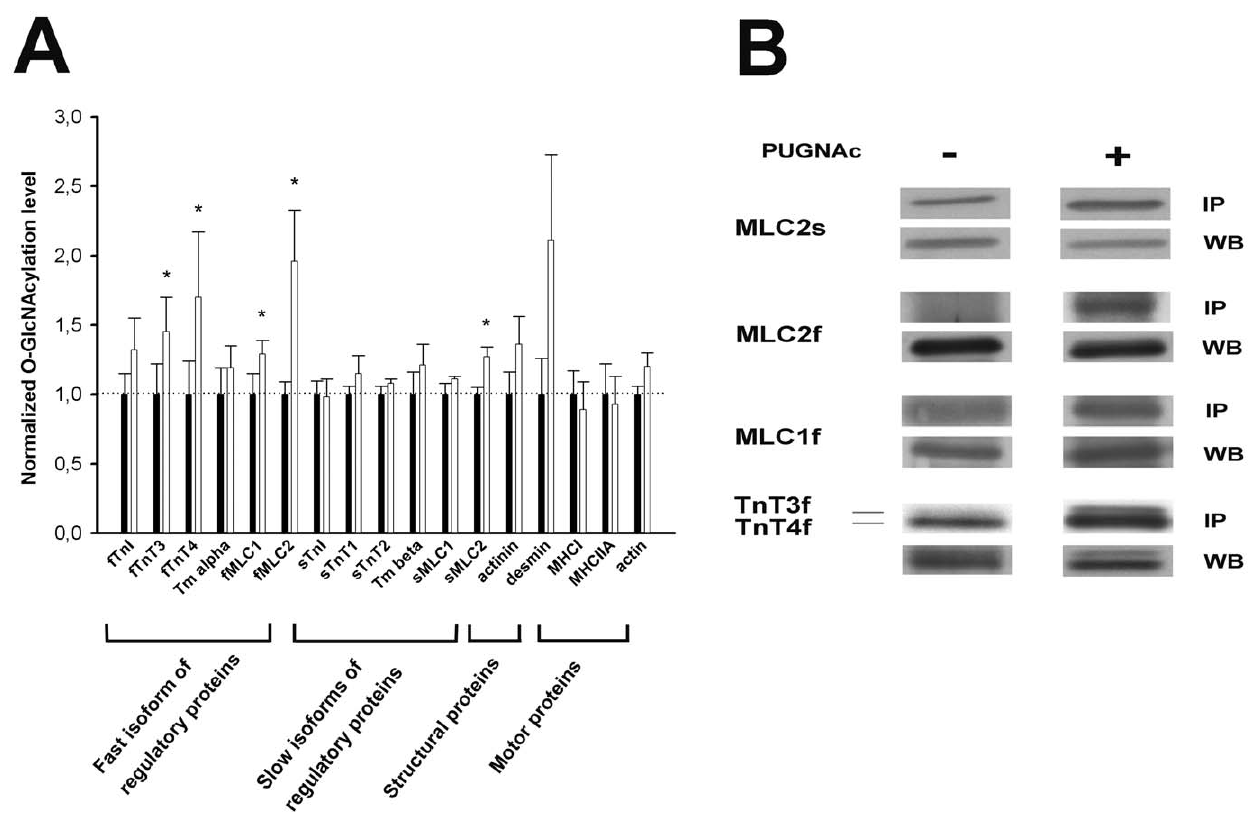
Figure 5. Quantification of O-GlcNAc variation on contractile protein after PUGNAc-treatment of soleus biopsies. Proteins extracted from skinned biopsies were RL-2 immunoprecipitated and separated on 10–20% SDS-PAGE. Densitometric analysis on QuantityOne software was performed on proteins of interest revealed using specific antibodies. (A) Results are expressed as ratio between signal obtained after RL-2 immunoprecipitation and signal obtained for whole protein level. Histograms correspond to O-GlcNAc level in PUGNAc-treated soleus comparing with untreated biopsies which were assigned to reference ( i.e. 1). Data are expressed as mean 6 SEM and are representative of 5 paired biopsies. *p , 0.05 PUGNAc vs untreated-treated biopsies. (B) Representative western blots of the proteins presenting variation in O-GlcNAcylation after PUGNAc treatment showing the O-GlcNAcylated form (IP) and the total expression (WB) of the protein in control ( 2 ) and PUGNAc ( + ) treated biopsies. Only the region of the protein of interest is shown.